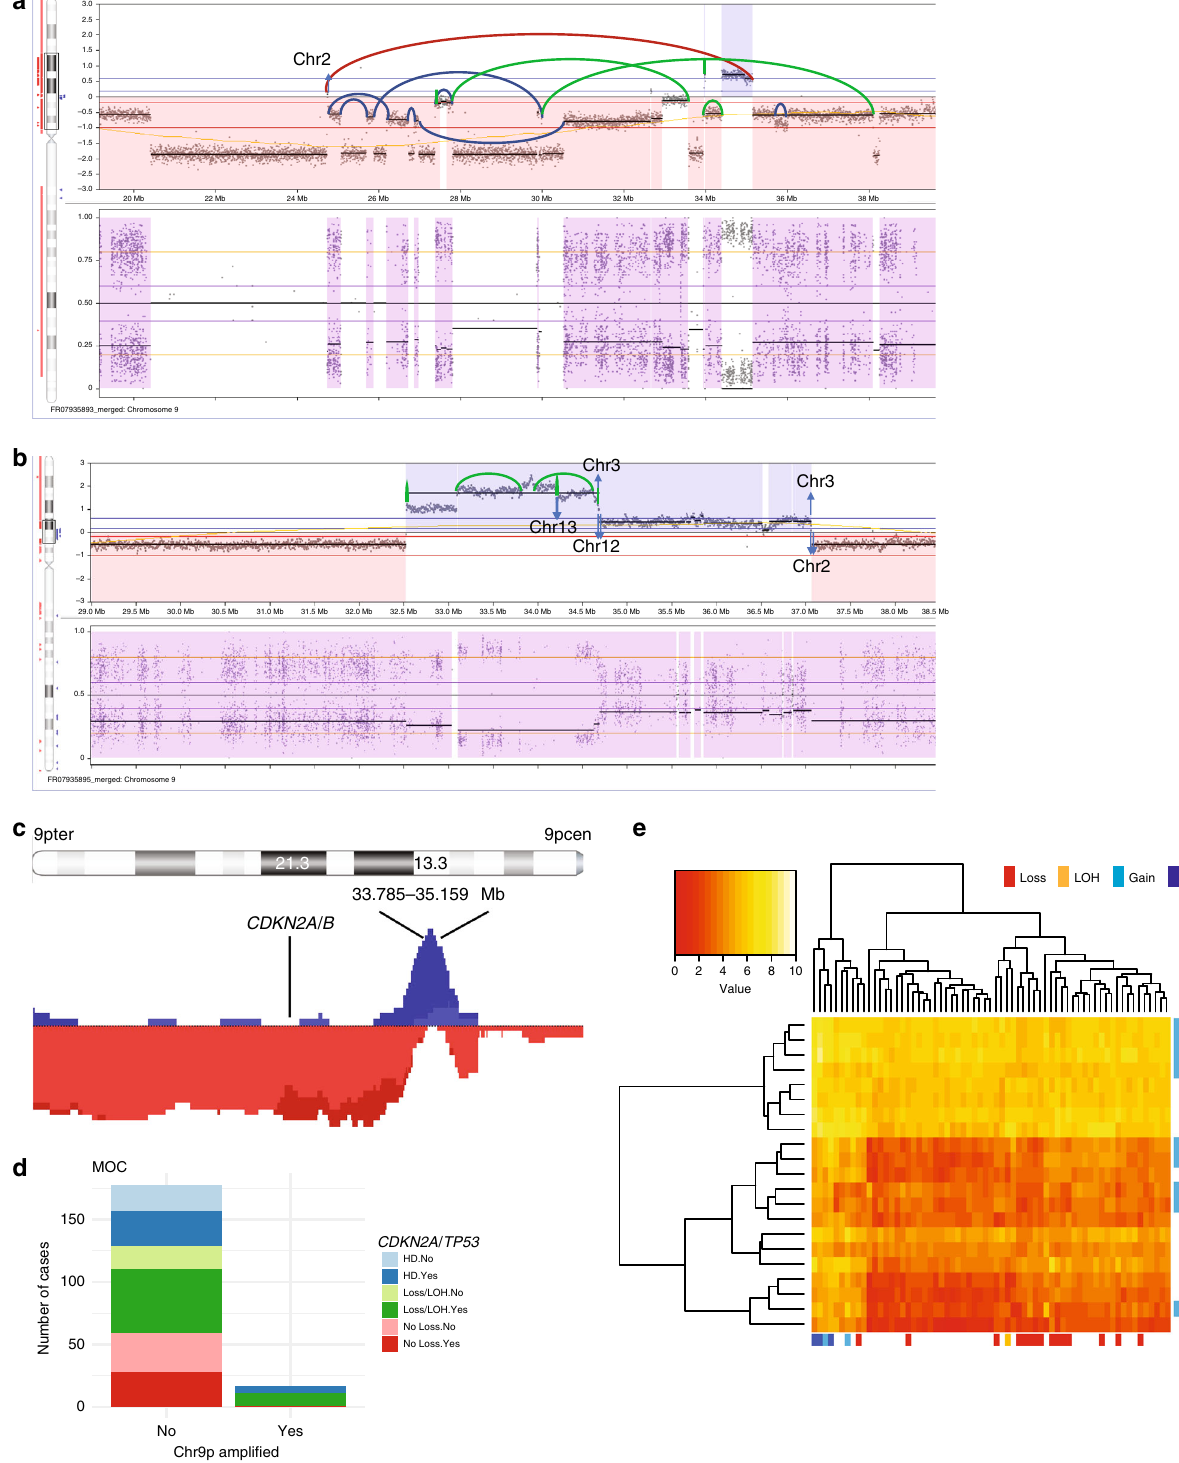
Fig. 3 9p13 ampli fi cation. a WGS case HOV159 showing complex ampli fi cation with the majority of breakpoints rejoining internally to chromosome 9. b WGS case 5950 showing simpler ampli fi cation with a mixture of internal and external breakpoint fusions. c Overview of all ampli fi ed samples (gains in blue, losses in red) showing minimal region of overlap at 33.785 – 35.159 Mb and association with 9p loss. d All MOC with 9p13 ampli fi cation have TP53 mutation and 16/17 also have have CDKN2A loss/loss of heterozygosity (LOH). HD, homozygous deletion. For TP53 : No: no mutation detected, Yes: mutation detected. e RNAseq analysis showing genes signi fi cantly differentially expressed between ampli fi ed and non-ampli fi ed (FDR < 0.05). Blue genes = within 9p amplicon, *genes connected in STRING network related to chromosome